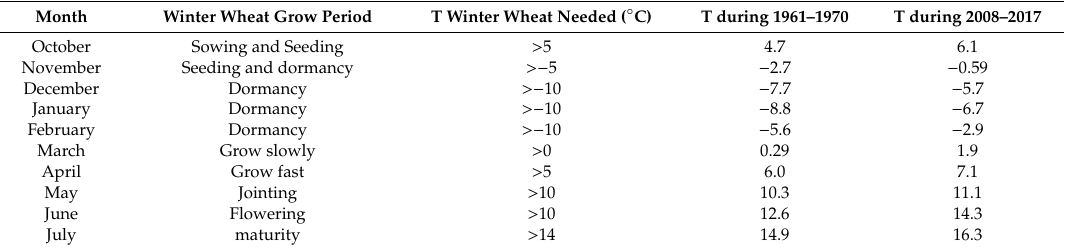
Table 1. Mean temperature and precipitation in 1961–1970 and 2008–2017, as well as temperatures needed for winter wheat growth in the wheat regions of the Tibetan Plateau,